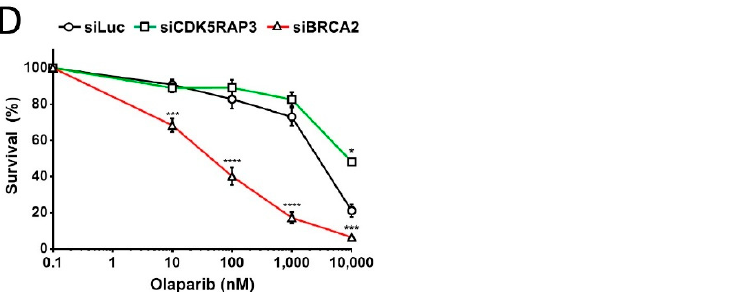
Figure 2. CDK5RAP3-depletion confers DNA damage resistance. ( A ) Clonogenic assay of U2OS cells transfected with siRNA targeting CDK5RAP3, BRCA2 or luciferase as a control (see materials and methods). Cells were plated and treated with different MMC (left) or ionizing radiation (right) doses for 10–14 days and Giemsa stained. Image shown is representative of at least three independent experiments with similar results. Right panel shows expression of siRNA targeted genes by Western blot. ( B , C ) Clonogenic assay graphs from averaged experiments done as in ( A ) in U2OS cells treated with MMC ( B ) or IR ( C ). ( D ) Survival assay of U2OS cells transfected as in ( A ), treated with different doses of PARP inhibitor olaparib. Graphs from ( B , C ) show mean ± SEM of at least 3 independent experiments. * p < 0.05, ** p < 0.01, *** p < 0.001, **** p < 0.0001.